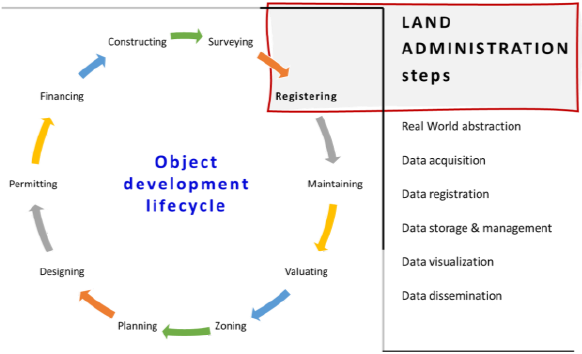
Figure 1 . Phases of the Spatial Development